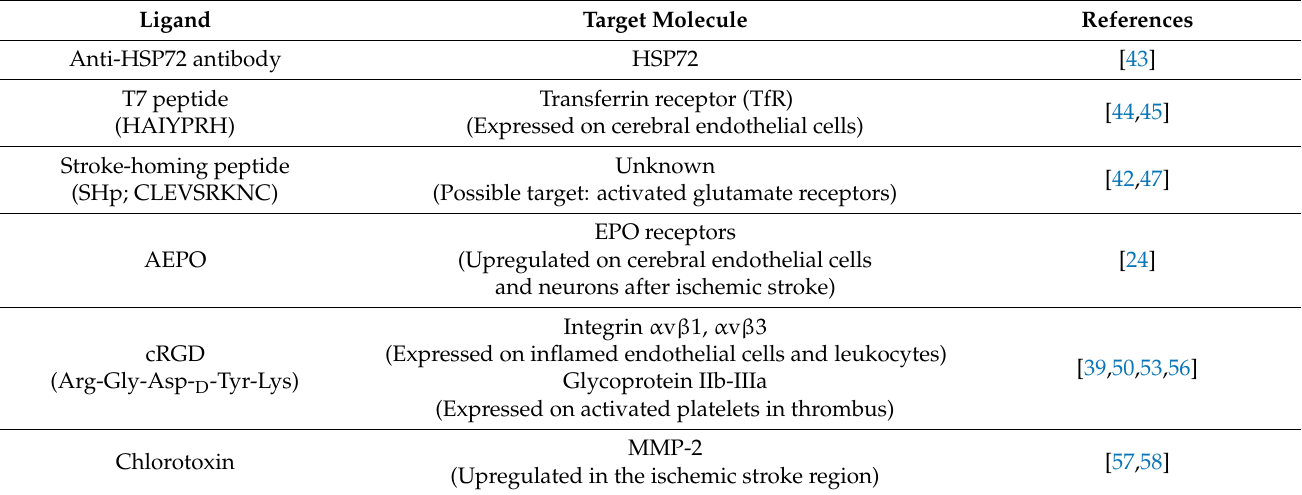
Table 2. List of ligands targeted to the ischemic stroke region, as described in this